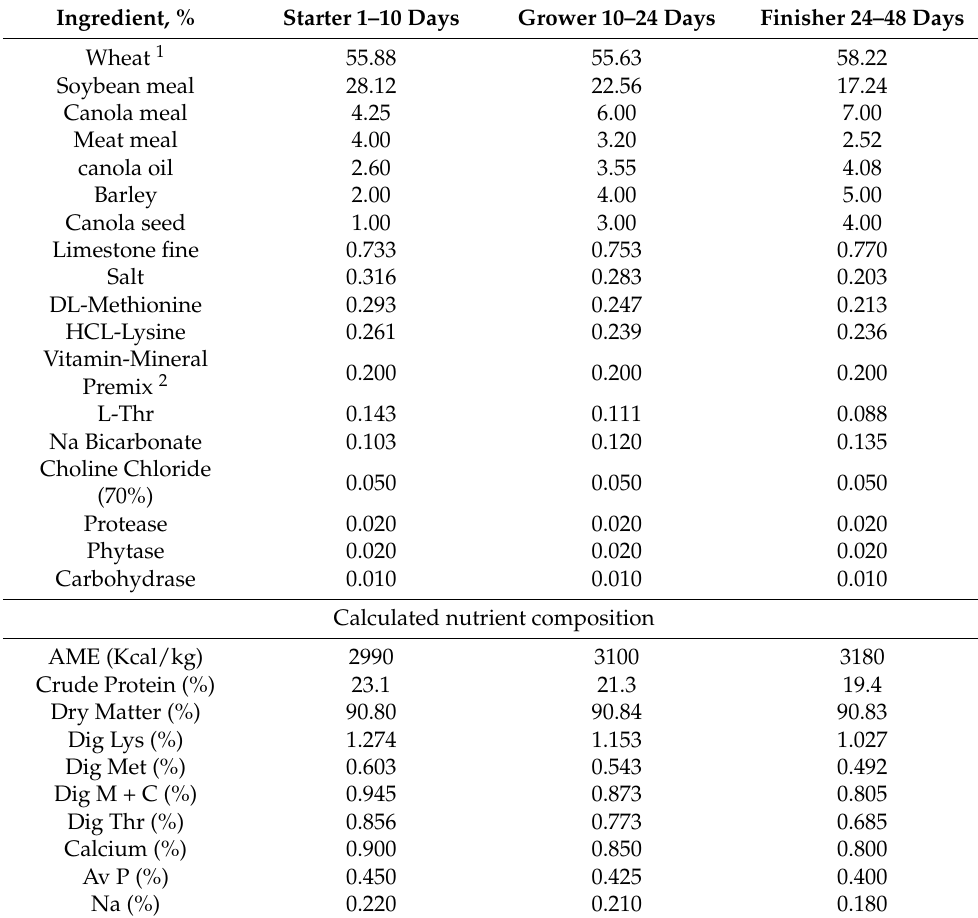
Table 5. Ingredient composition and nutritional specifications of experimental diets (Trial